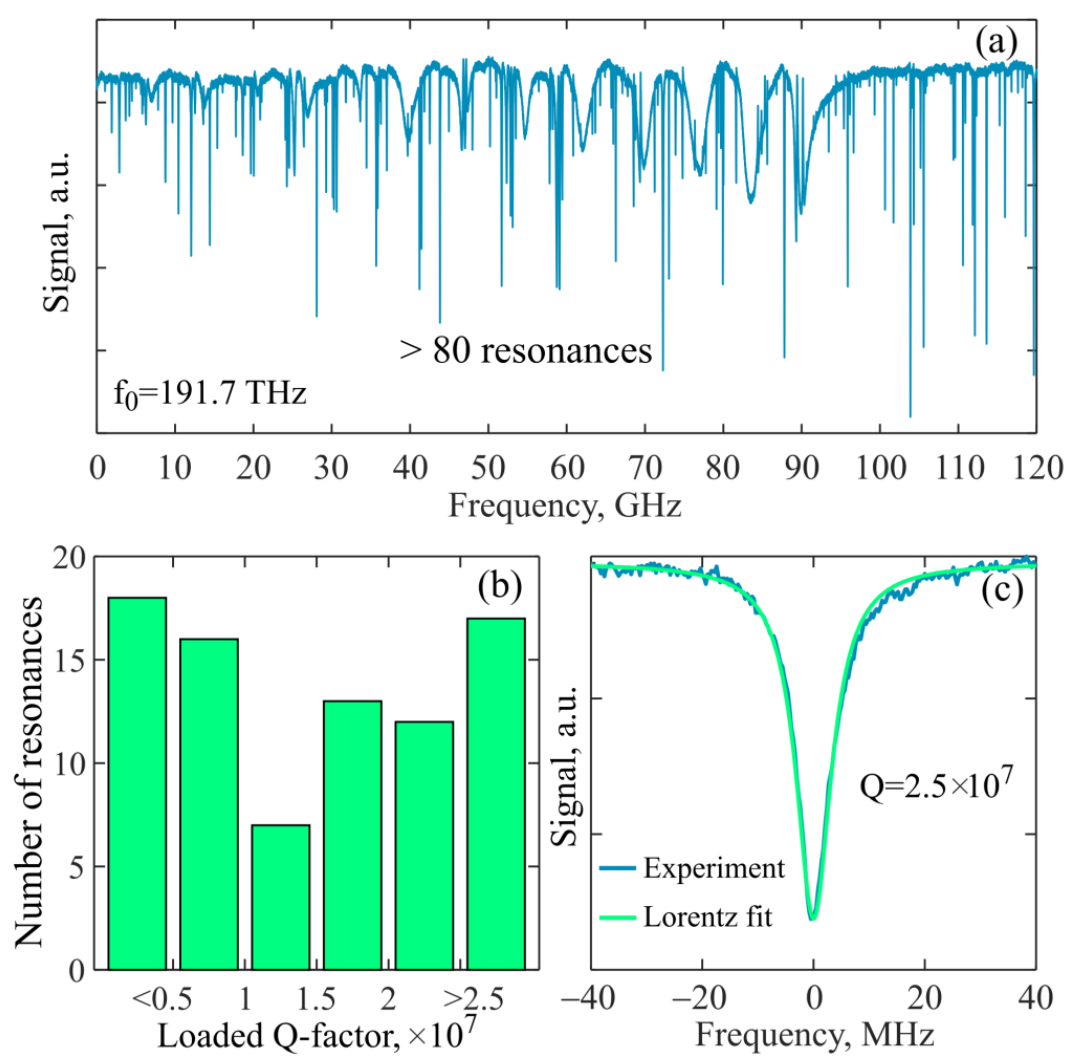
Figure 6. ( a ) Experimental resonance dips of eigenmodes of the produced 75 µ m tellurite microsphere resonator recorded for the output pump power of 0.3 µ W with the oscilloscope at the pump-laser-sweeping rate of 10 GHz/s. ( b ) Statistics of Q-factors for these resonances. ( c ) Resonance dip on magnified scale and its Lorentz approximation demonstrating loaded